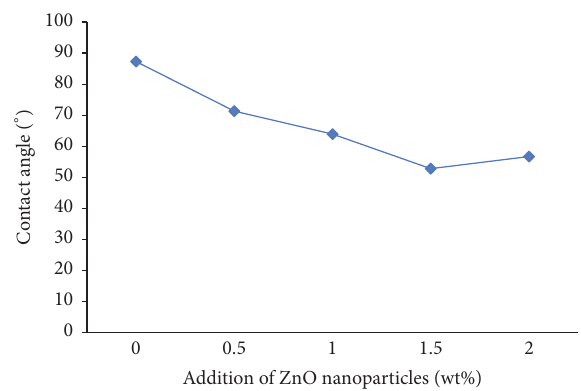
Figure 3: Contact angle measurements of composite ZnO/PES membranes at different amounts of ZnO nanoparticles from (0, 0.5, 1, and 1.5 to 2